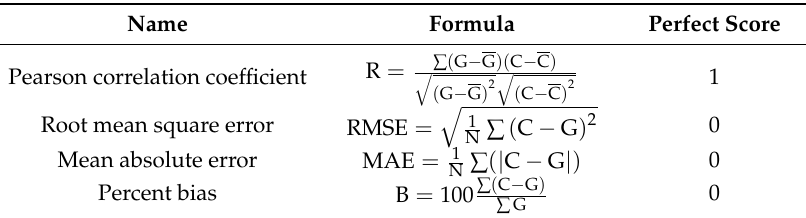
Figure 3. Flowchart of the summarized research design and method.